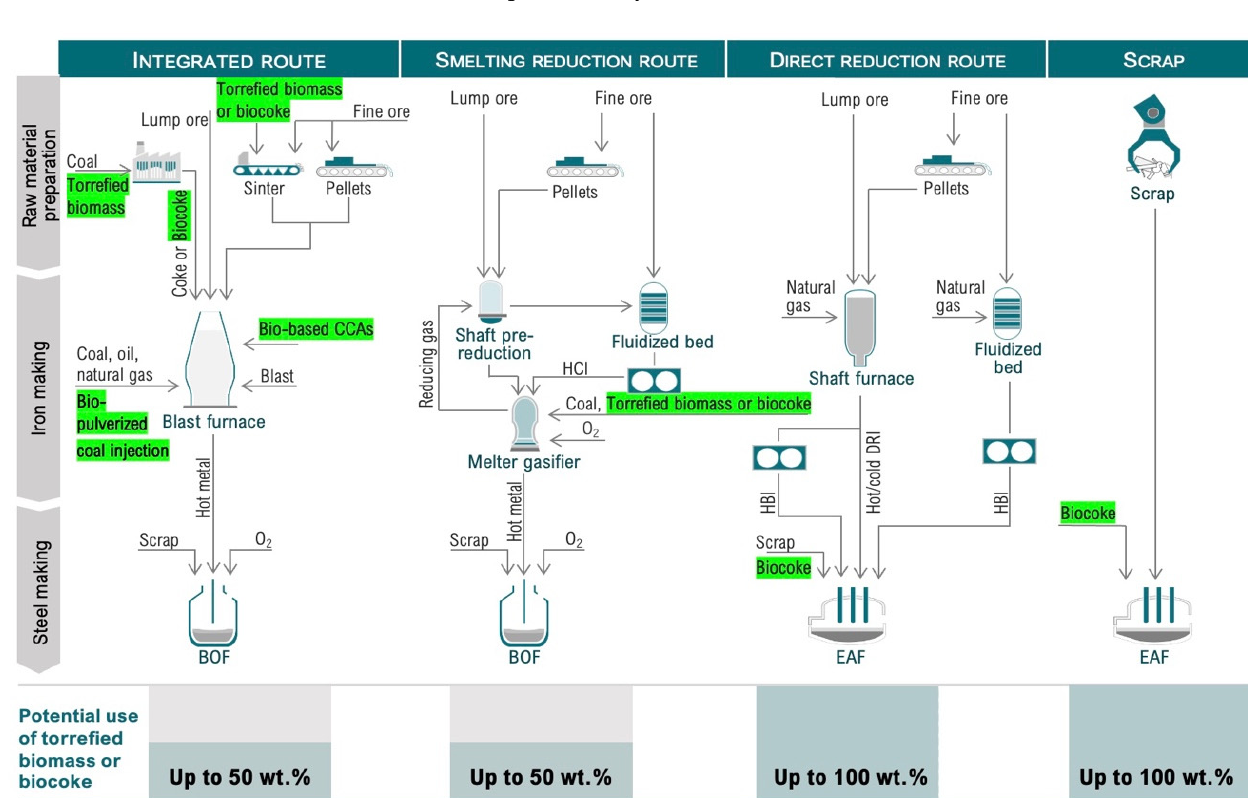
Figure 3. Main pathways for using secondary carbon bio-carriers in iron and steelmaking units.